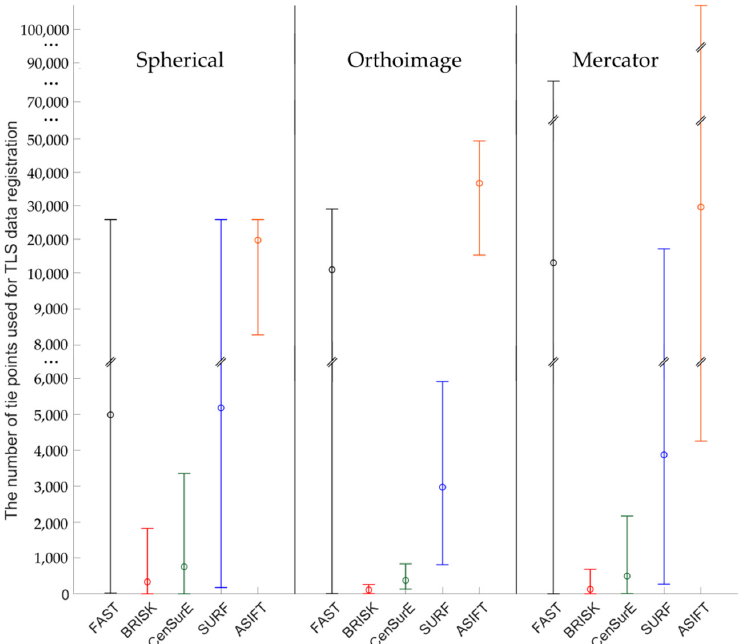
Figure 9. Diagram of the mean (circles), maximum, and minimum percentage of correctly detected and matched key points using blob (ASIFT, SURF, and CenSurE) and point (FAST and BRISK) detectors for rasters in the spherical projection, orthoimages, and the Mercator projection; Test Site II.